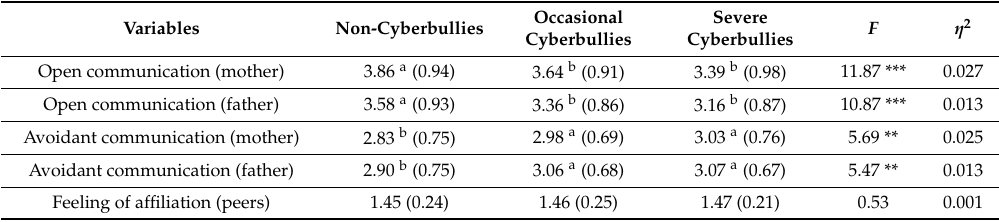
Table 2. Mean (Standard Deviation), ANOVA of differences between cyberbully groups in variables family communication and feeling of affiliation.